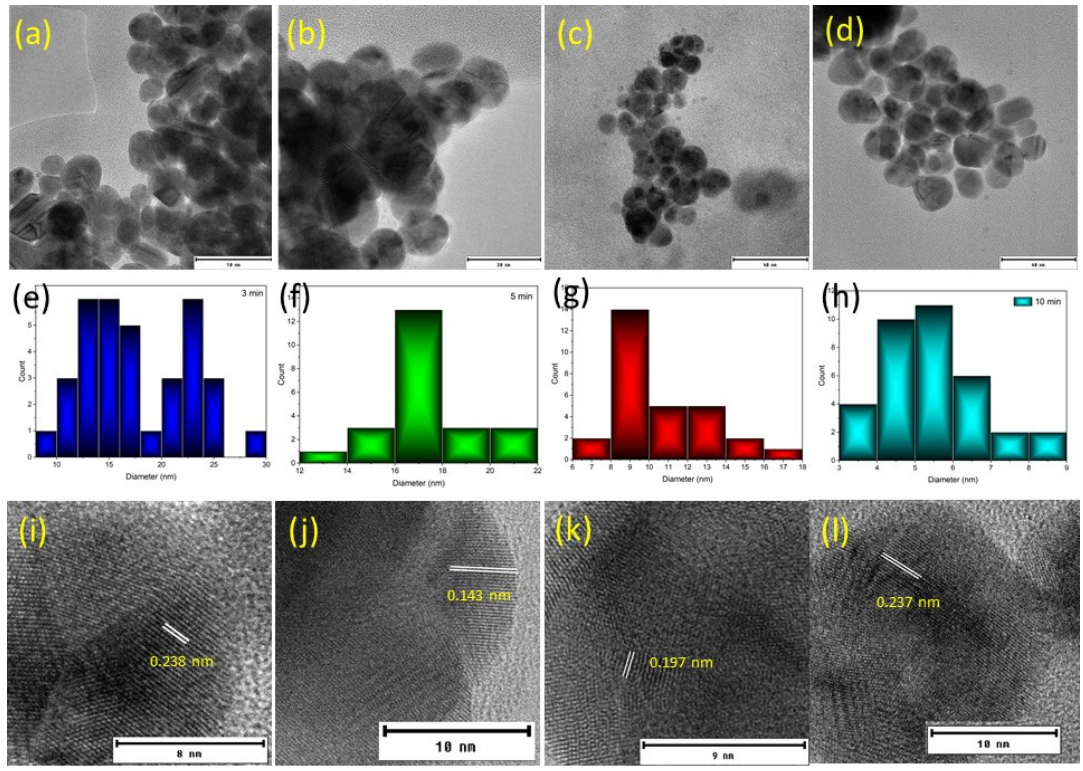
Figure 3. Transmission Electron Microscopy (TEM) images of the nanoparticles synthesised under different plasma exposure times: ( a ) 3 min, ( b ) 5 min, ( c ) 7 min, ( d ) 10 min; size distribution of the nanoparticles determined from TEM: ( e ) 3 min, ( f ) 5 min, ( g ) 7 min, ( h ) 10 min; HRTEM of nanoparticles ( i ) 3 min, ( j ) 5 min, ( k ) 7 min, ( l ) 10 min.